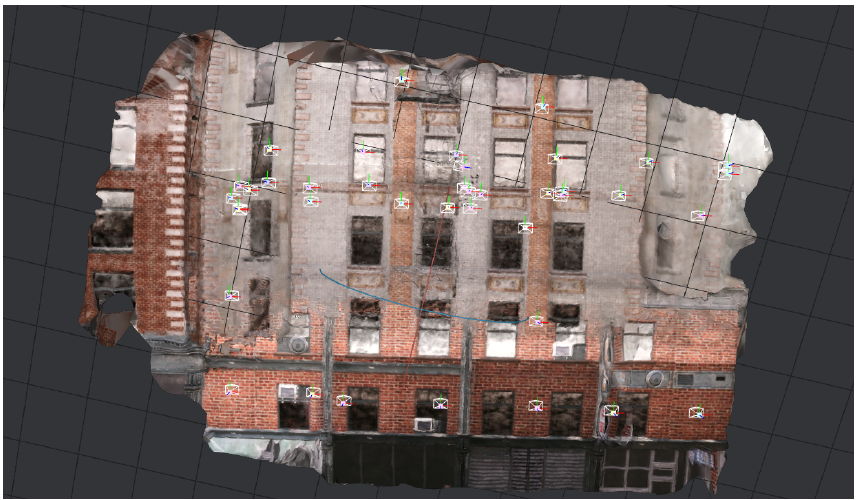
Figure 10. Result of 3D visualization in